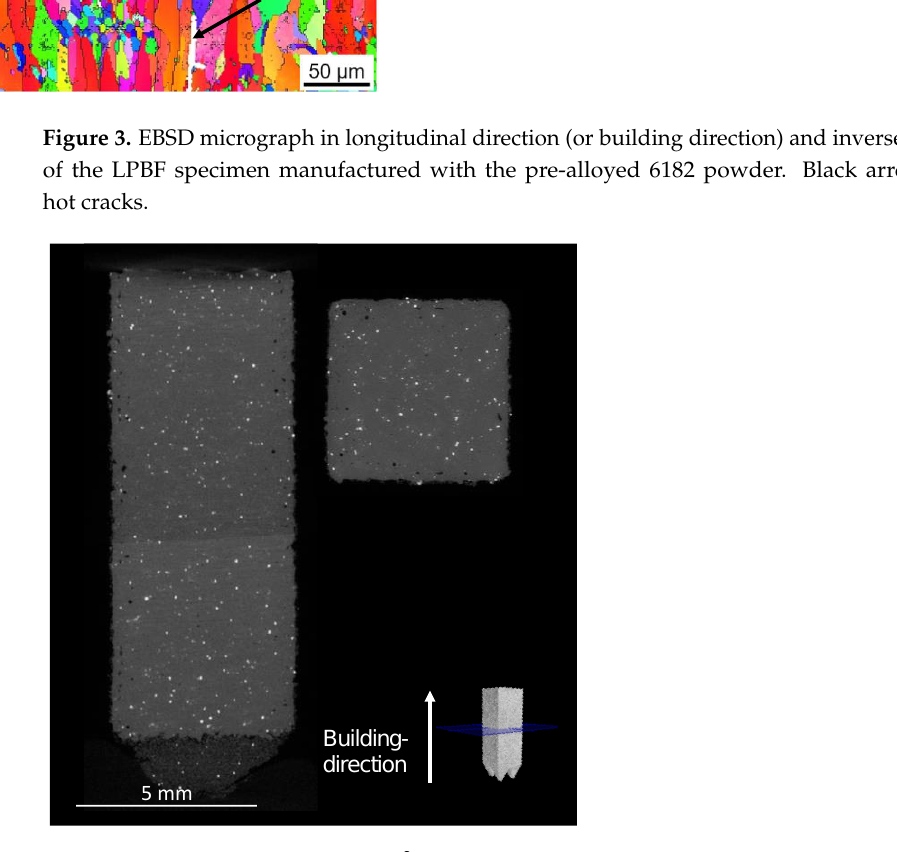
Figure 3. EBSD micrograph in longitudinal direction (or building direction) and inverse pole figures of the LPBF specimen manufactured with the pre-alloyed 6182 powder. Black arrows indicate hot cracks.